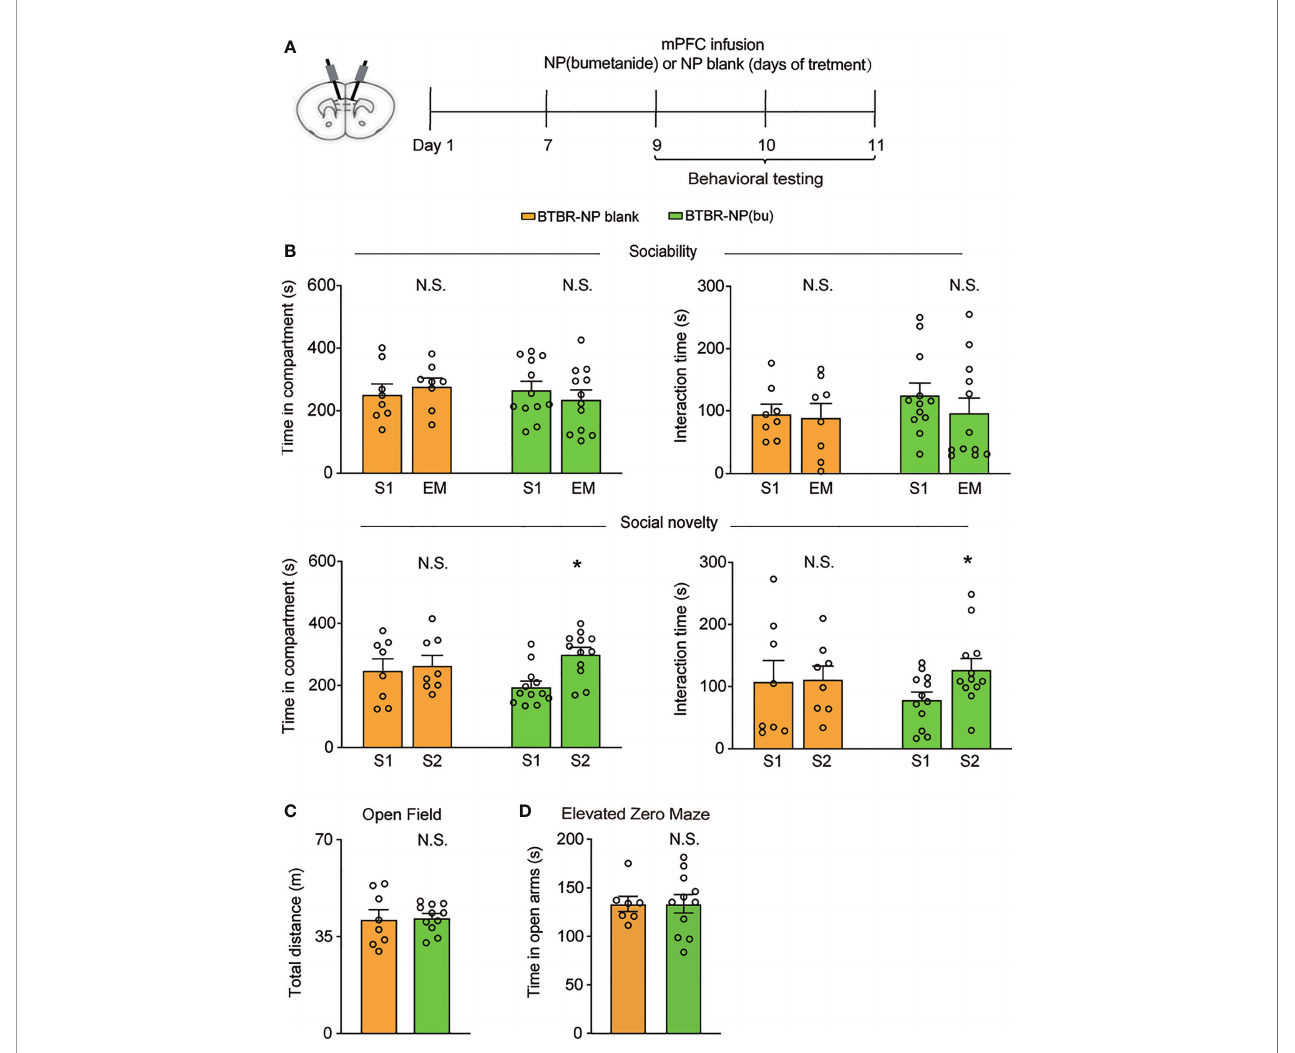
FIGURE 4 | mPFC region speci fi c administration of NP(bumetanide) alleviated social de fi cits in BTBR mice. (A) Schematic representation of the experimental procedure. Male BTBR mice were intra-mPFC infusion of NP(bumetanide) (100 m M) or NP blank. (B) Top: time spent in the social stimulus or empty chamber and total interaction time with stimulus mouse or empty wire during sociability stage (BTBR-NP blank, n = 8; BTBR-NP(bumetanide), n = 12, paired Student ’ s t -test. Time in compartments, N.S., not signi fi cant, BTBR-NP blank S1 vs. EM; N.S., not signi fi cant, BTBR-NP(bumetanide) S1 vs. EM; interaction time, N.S., not signi fi cant, BTBR-NP blank S1 vs. EM; N.S., not signi fi cant, BTBR-NP(bumetanide) S1 vs. EM). Bottom: time spent in familiar or novel stimulus chamber and total interaction time with familiar or novel stimulus mouse during social novelty stage (paired Student ’ s t -test. Time in compartments, N.S., not signi fi cant, BTBR-NP blank S1 vs. S2; * p <0.05, BTBR-NP(bumetanide) S1 vs. S2; interaction time, N.S., not signi fi cant, BTBR-NP blank S1 vs. S2; * p <0.05, BTBR-NP(bumetanide) S1 vs. S2). (C) Total distance traveled in the open- fi eld test (BTBR-NP blank, n = 8; BTBR-NP(bumetanide), n = 11, unpaired student t -test, N.S., not signi fi cant). (D) Time spent in the open arm in elevated zero maze test (BTBR-NP blank, n